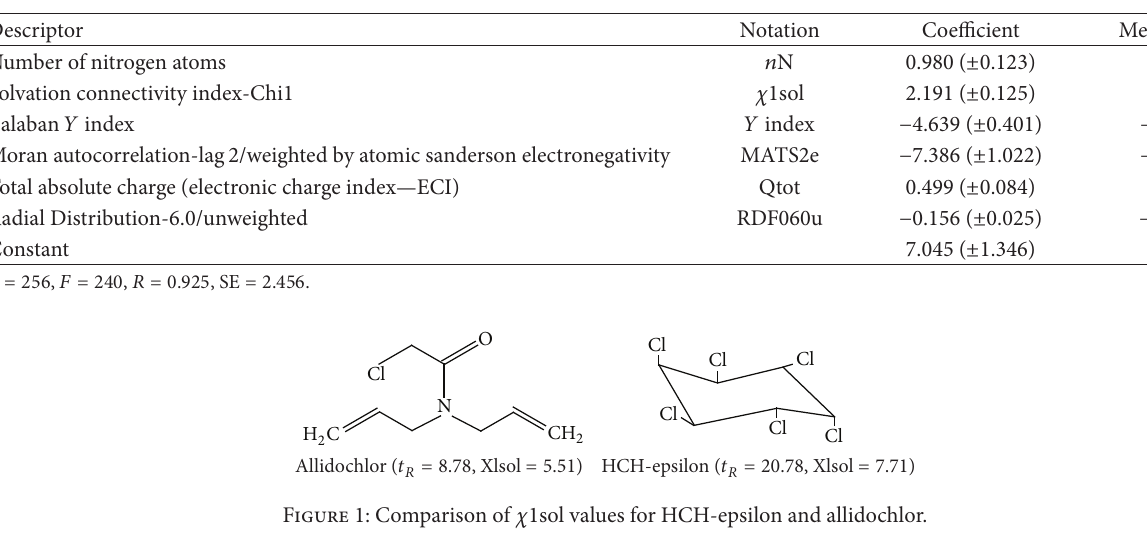
T 2: Speci�cations of the selected multiple linear regression model.